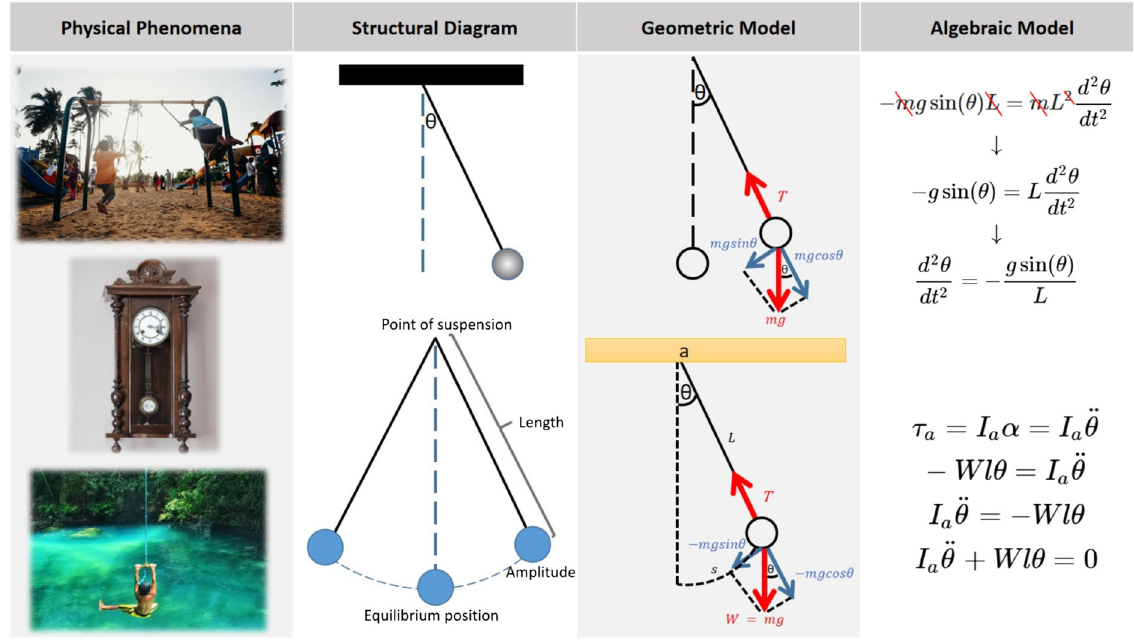
FIG. 3. Four general steps underlying many derivations in physics. The derivation of the equation of motion of a simple pendulum (analyzed in the lab frame) is deconstructed along the four steps, as an illustrative